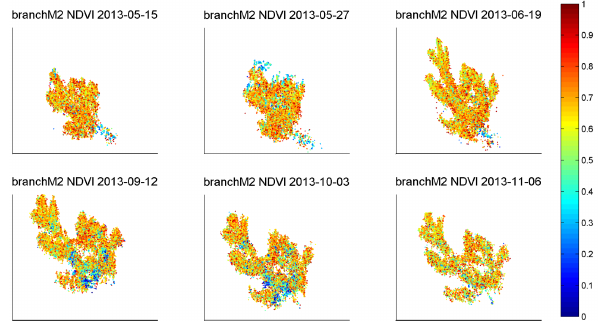
Figure 2. NDVI (see the colour bar for values) point clouds of a sample branch M2. The growth of new needles (starting 27 May), already clearly visible new branch tips 19 June, fully grown new needles 12 September and dying and falloff of old needles (low NDVI in 12 September and 03 October) are visible in the data mea- sured at different times. The measurement dates are shown in the plot titles.